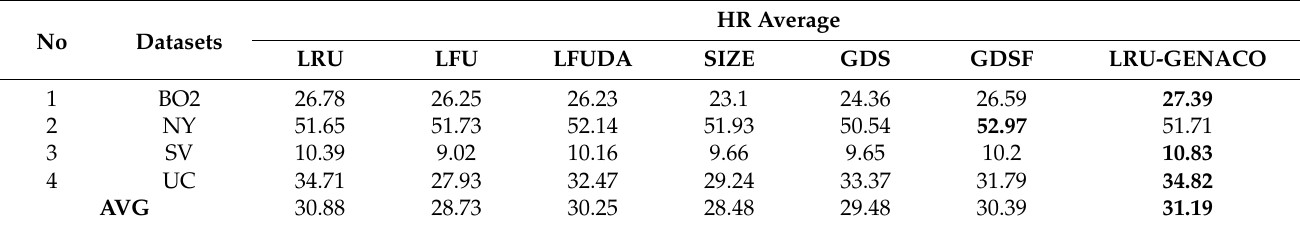
Table 2. HR average comparison over conventional caching